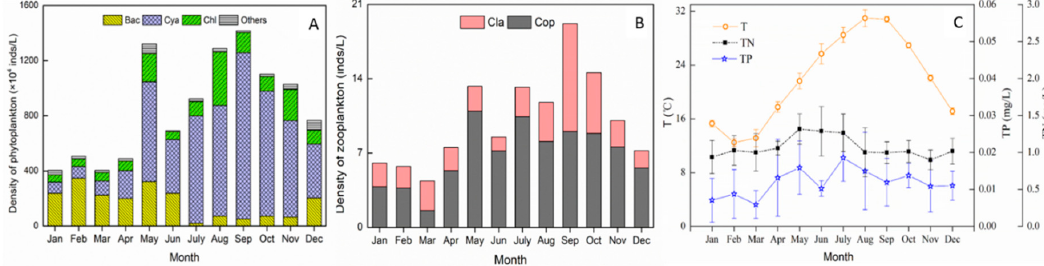
Figure 3. Seasonal variations of water parameters and densities of plankton. T, TN and TP represent water temperature, total nitrogen and total phosphorus, respectively. Bac, Cya, Chl, Cop and Cla represent bacillariophyta, chlorophyta, cyanophyta, copepoda and cladocera, respectively, in plankton.